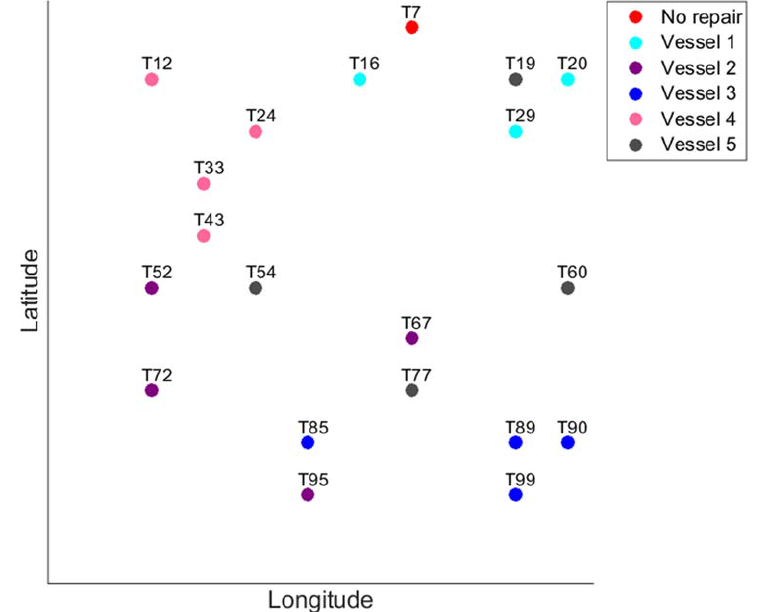
Figure 3. Vessel dispatch plan for Case 1. This figure, with arrows indicating individual vessel movements, is shown in Figure S2 in the Supplementary Material.